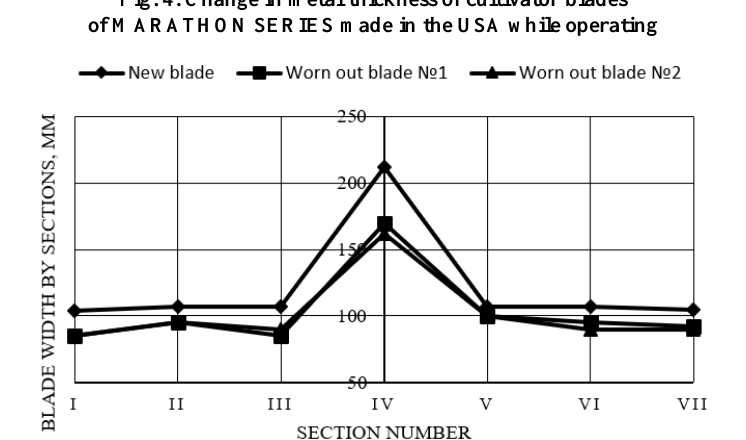
Fig. 5. Change of cultivator blades sizes of MARATHON SERIES made in the USA by sections (see. Fig.